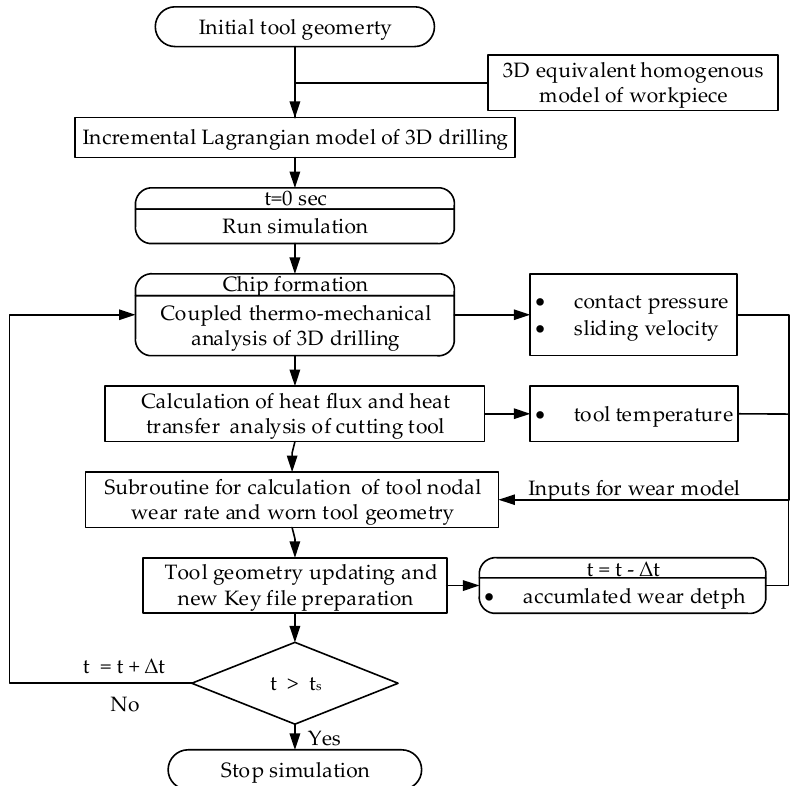
Figure 4. Flowchart of tool wear calculation procedure using FEM.